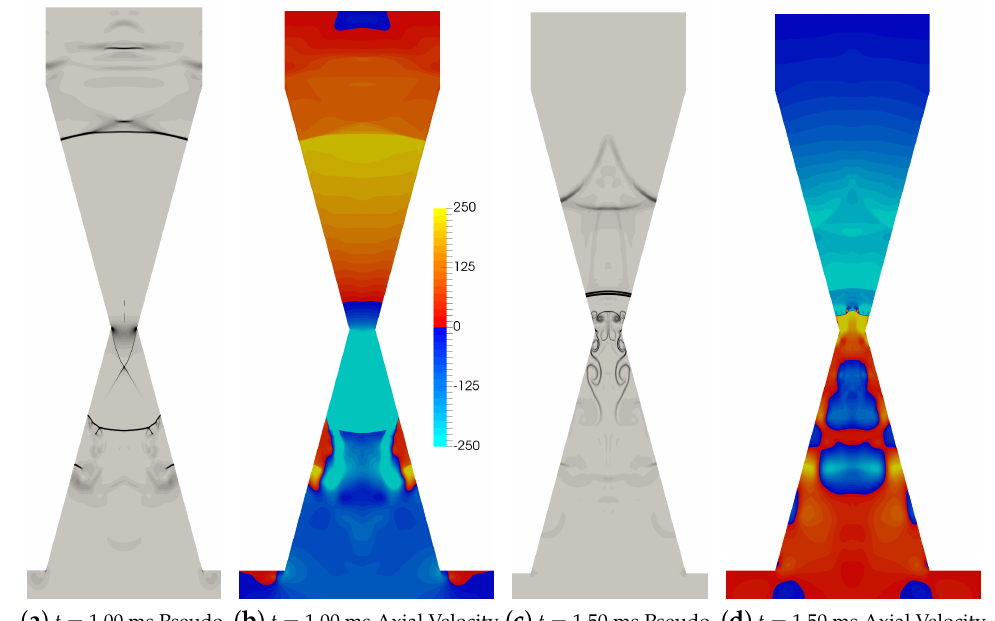
Figure 12. Simulated flow state at the first maxima in thrust ( t = 1.00 ms) and the first minima ( t = 1.50